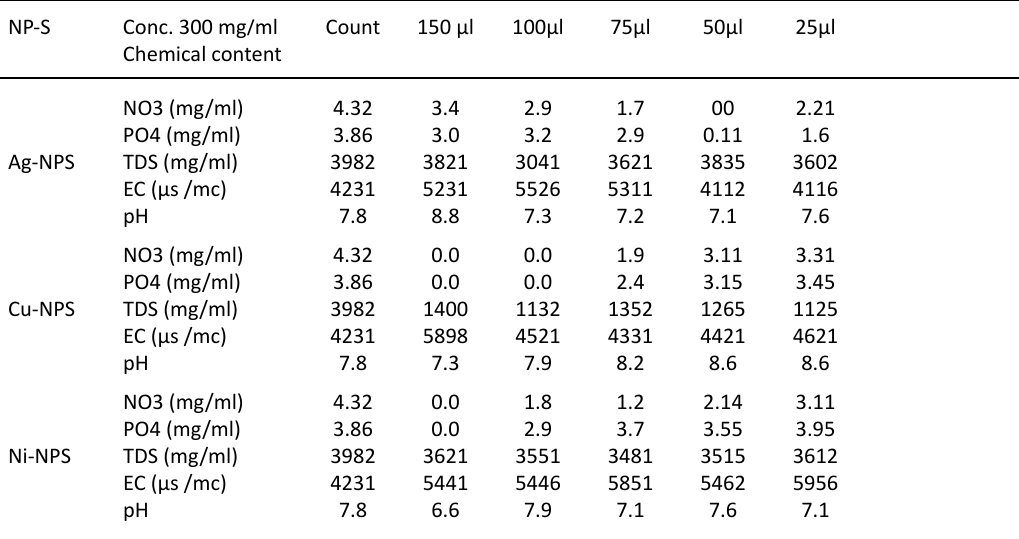
Table 5. Effect of Ag-NPS, CU-NPS, Ni-NPS, synthesized by ginger on chemical and physical properties of Mariout lake water sample NP-S Conc. 300 mg /ml Count Chemical content